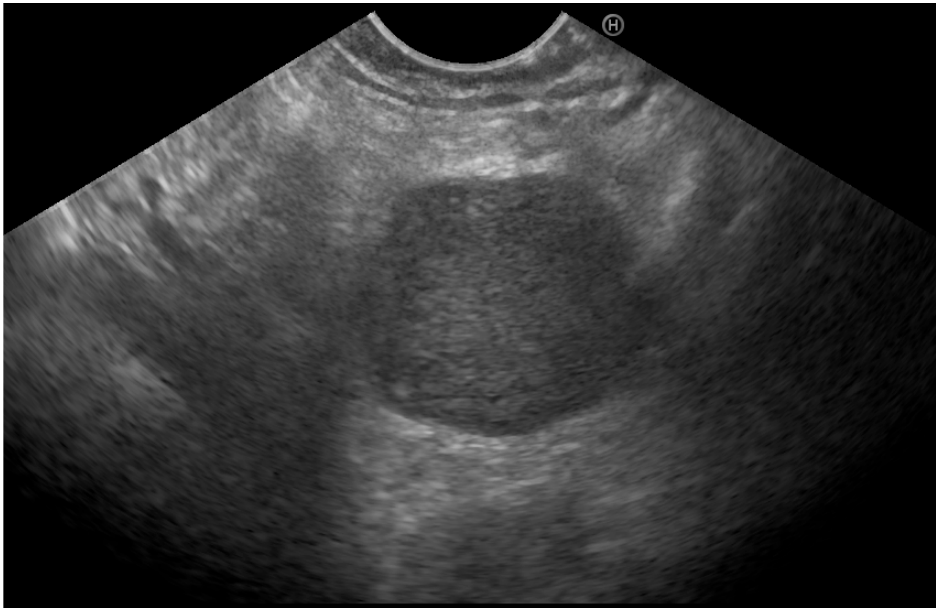
Figure 3. Endoscopic ultrasound using a linear probe positioned in the duodenum, showing a hypoechoic round mass in the head of the pancreas.